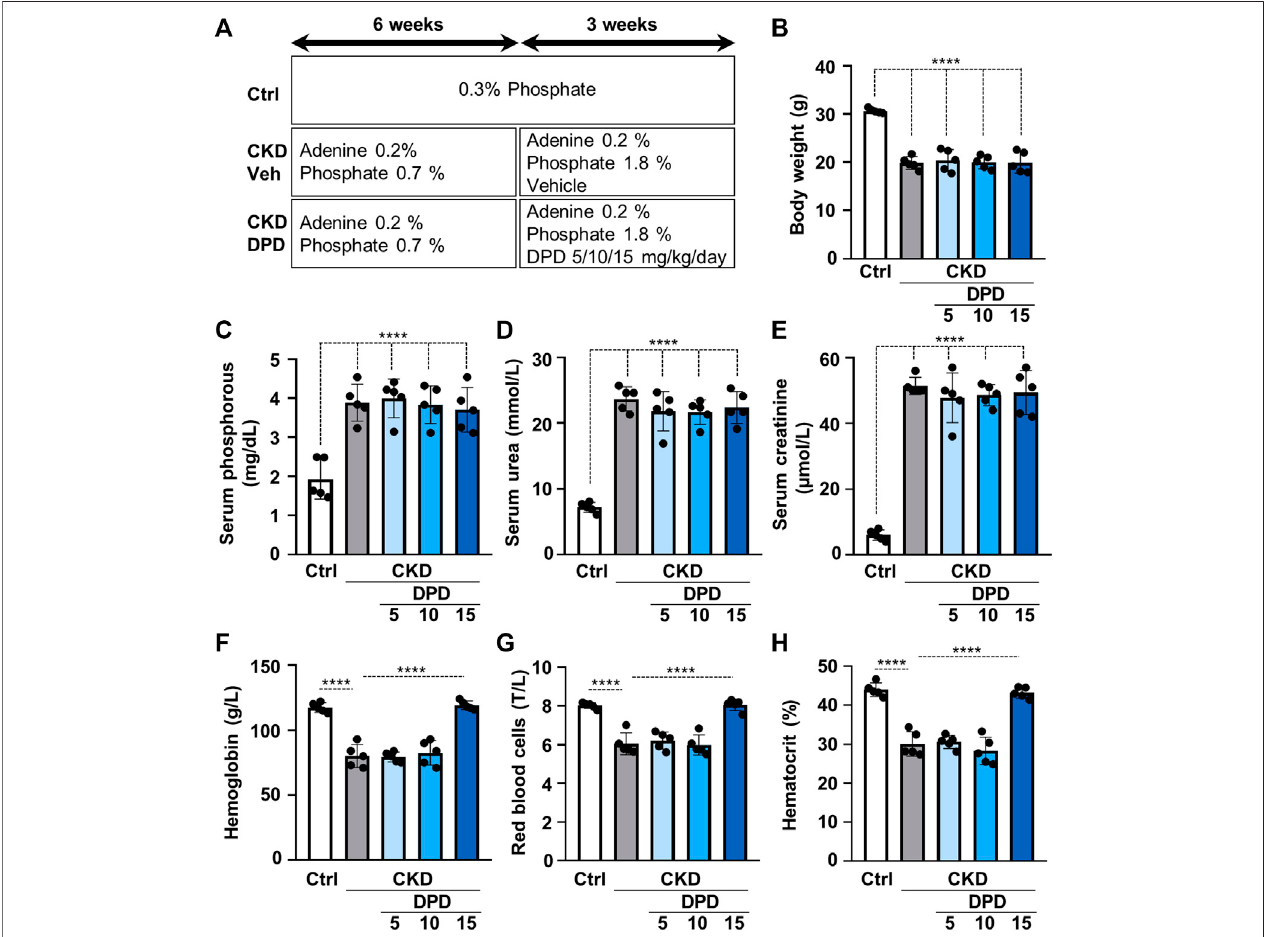
FIGURE 4 | Dose-dependent effect of DPD treatment on renal function and anemia in C57BL/6 mice fed an adenine plus high Pi diet. (A) Scheme of the experimentalprotocol. (B) Bodyweight, (C) serumphosphorous, (D) serumurea, (E) serumcreatinine, (F) wholebloodhemoglobinconcentrationwith (G) redbloodcell count (T/L), and (H) hematocrit values were determined. Dataare expressed as mean ± SD, n = 5. Ordinary one-way ANOVAfollowed by Tukey ’ s multiple comparisons test were used to calculate p values. **** p < 0.001.